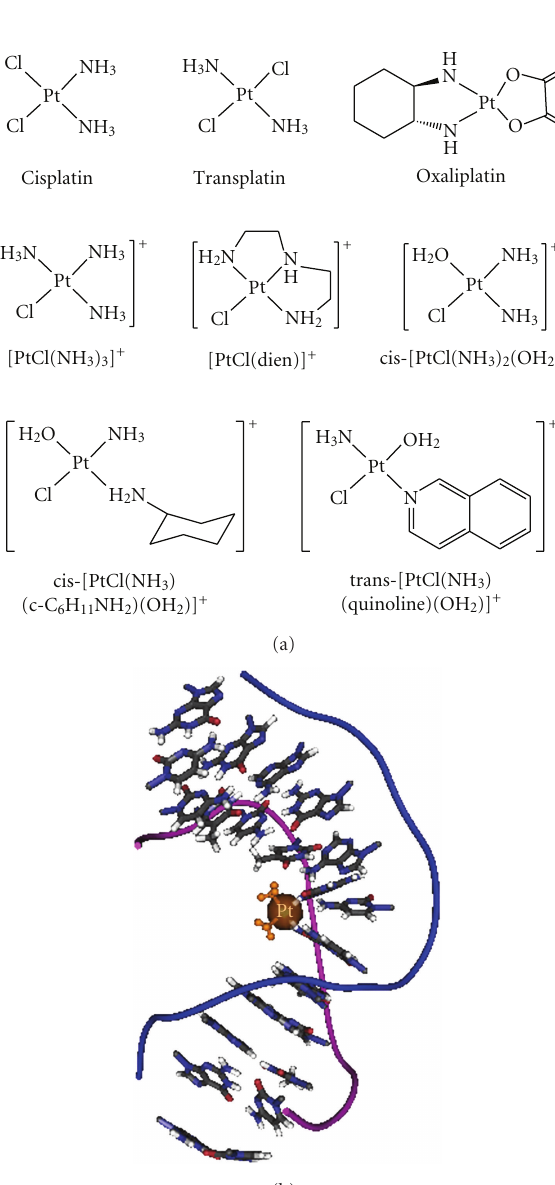
Figure 3: Platinium derivatives. (a) Examples of platinated agents inducing local destabilization of the DNA helix. (b) The three- dimensional organization of cisplatin bound to DNA are drawn from crystallographic data [mmdbId:47796] [92] and evidenced strong DNA bending induced by cisplatin on a duplex DNA decamer oligonucleotide that fits with the L-shape angle of HMG- box DNA-binding